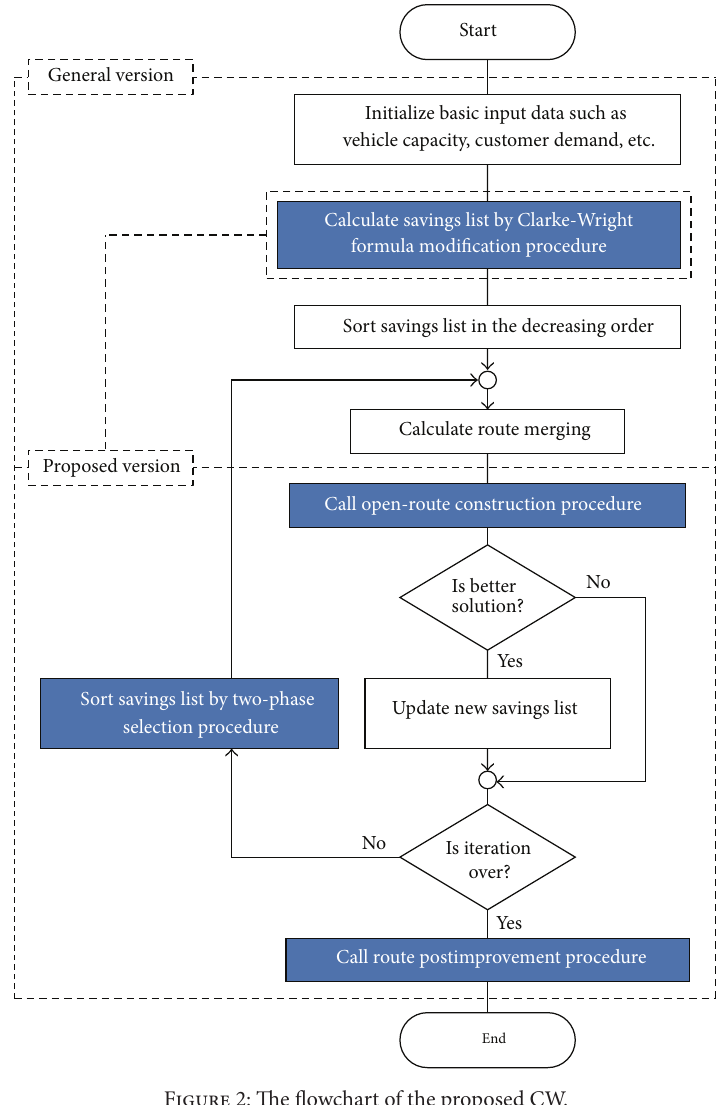
Figure 2: The flowchart of the proposed CW.